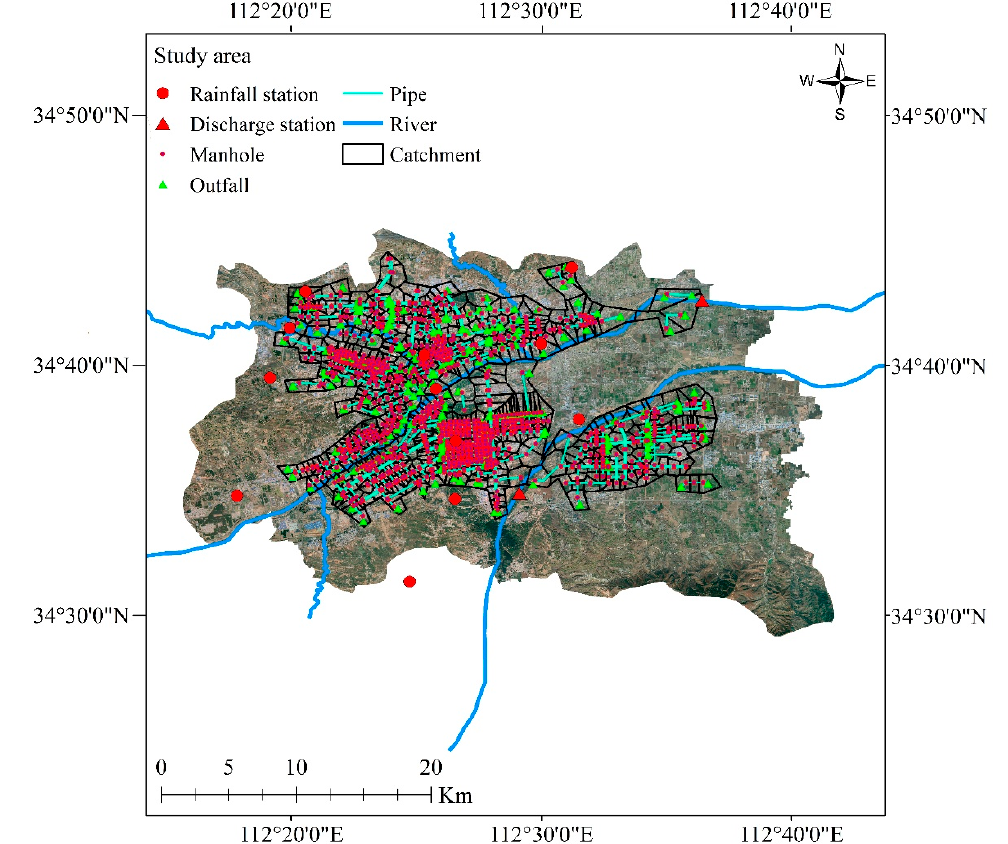
Figure 2. Research region and sewer system distribution. We selected Luoyang city center, in the northern Henan Province of China, as our study area (34°29 ′ 06 ″ –34°45 ′ 47 ″ N, 112°15 ′ 44 ″ –112°41 ′ 57 ″ E, at 150 m asl) (Figure 1). Luoyang city center, which constitutes the northern part of Luoyang city,